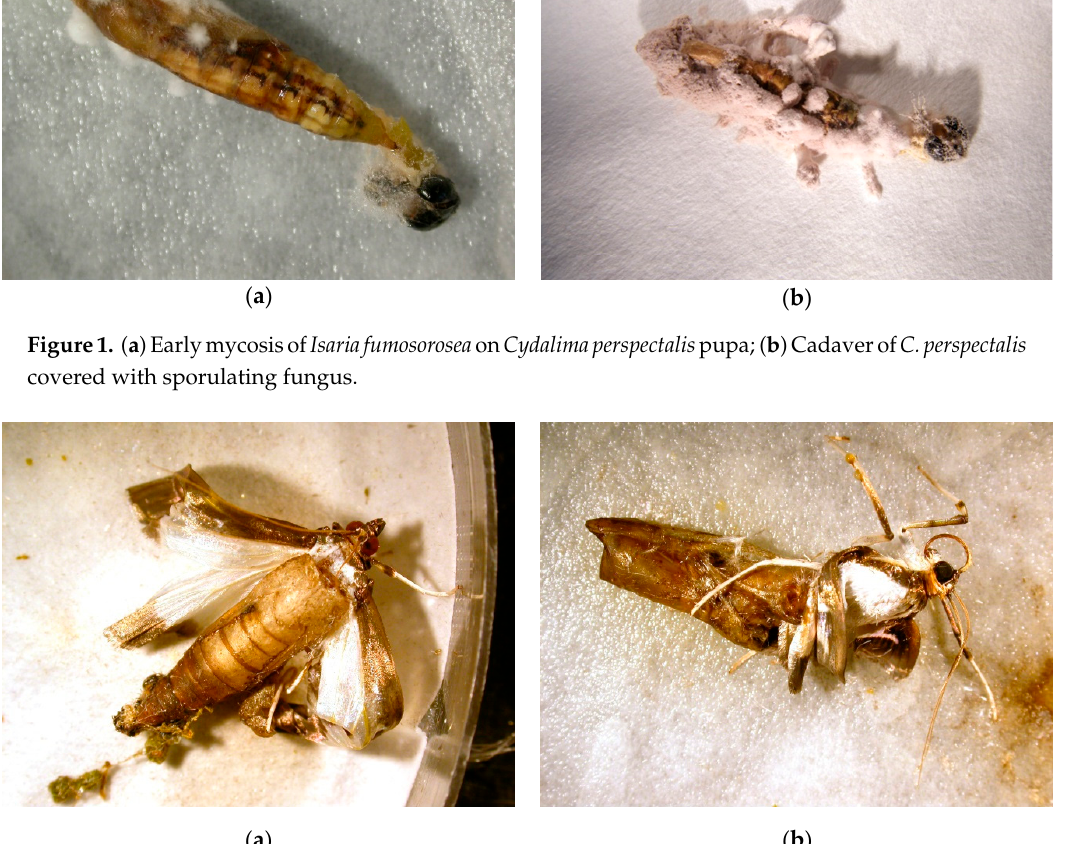
Figure 2. ( a , b ) Malformed adults of Cydalima perspectalis emerged in a group of larvae treated by Isaria fumosorosea at a concentration 1 × 10 8 conidia/mL. Isaria fumosorosea at a concentration 1 × 10 8 conidia /